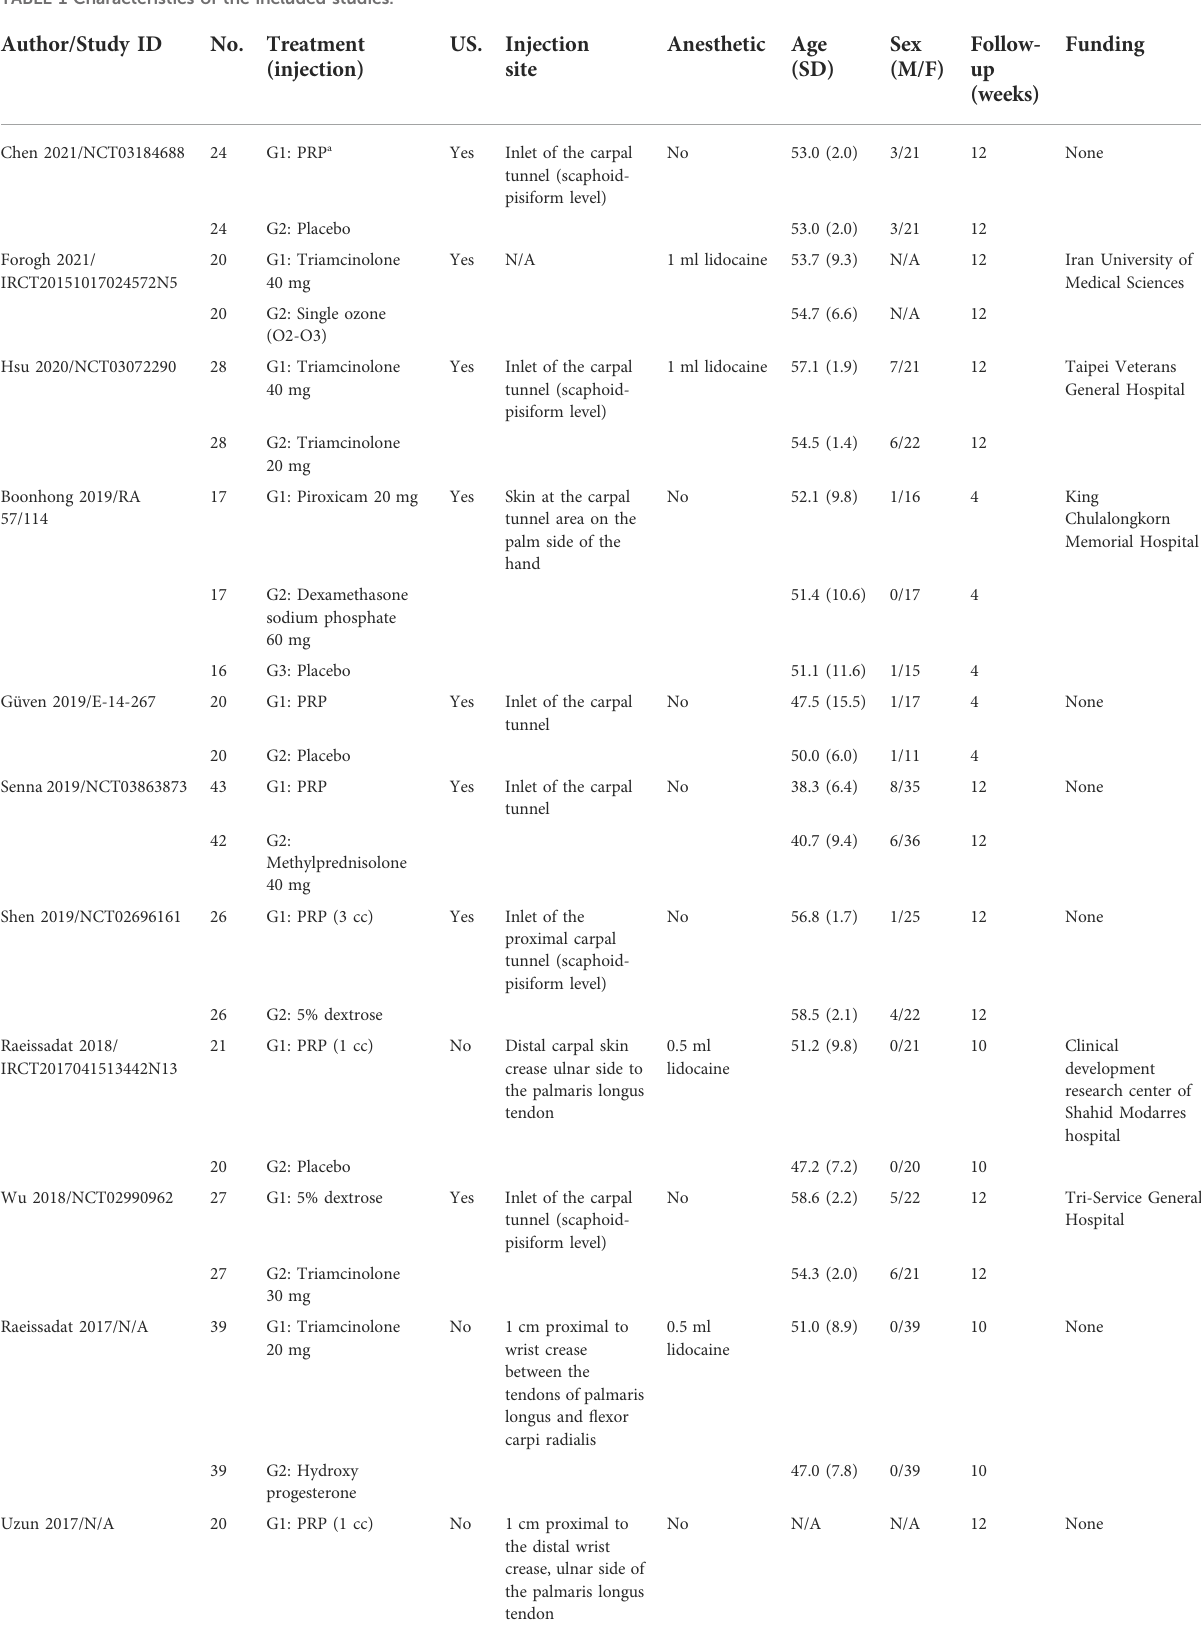
TABLE 1 Characteristics of the included